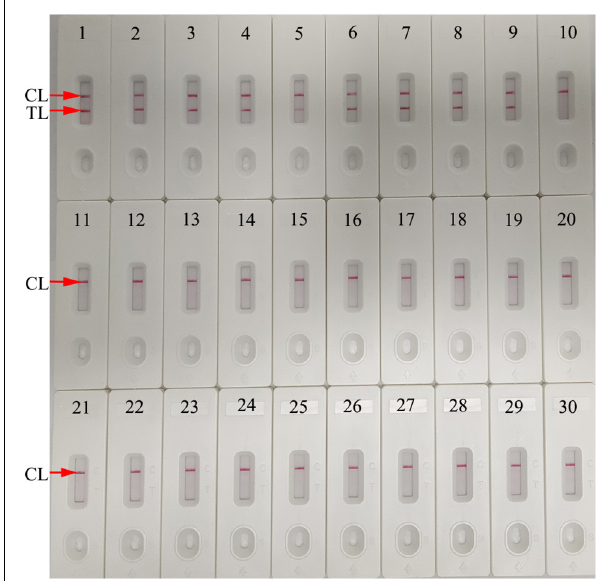
FIGURE 7 | Assay specificity using different pathogens. The N. gonorrhoeae- MCDA-LFB assay was verified using different genomic RNA/DNA as templates. Biosensor 1, N. gonorrhoeae (ATCC 49926); Biosensors 2–9, N. gonorrhoeae (clinical samples); Biosensor 10, Neisseria meningitides ; Biosensor 11, Chlamydia trachomatis ; Biosensor 12, Enteropathogenic Escherichia coli ; Biosensor 13, Haemophilus influenzae